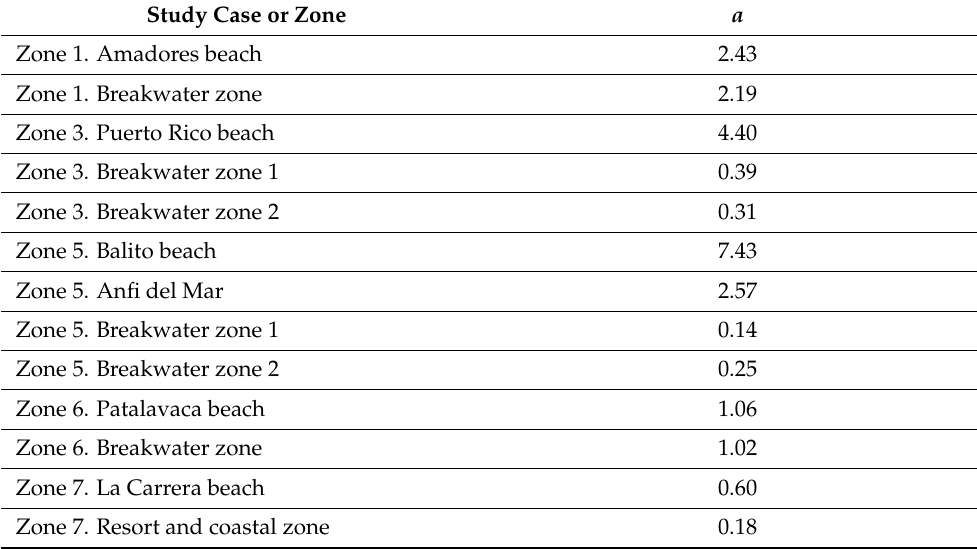
Table 4. Adjustment factor used to calculate the prediction of the SLR-related economic